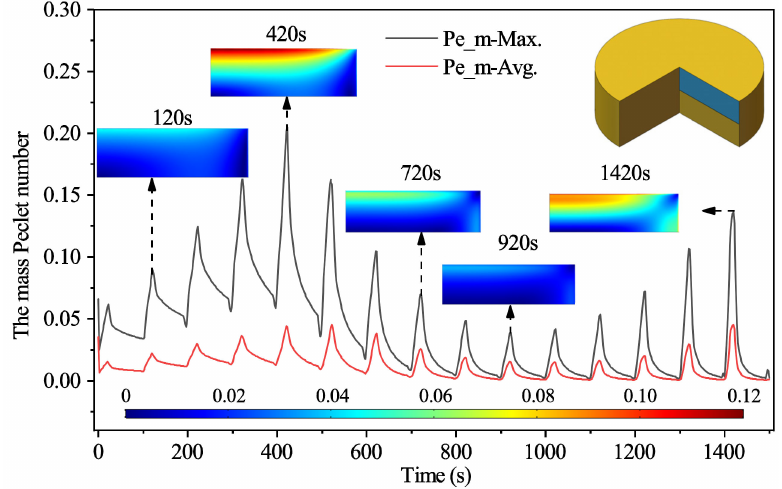
Figure 8. The maximum and average mass Pe numbers at different